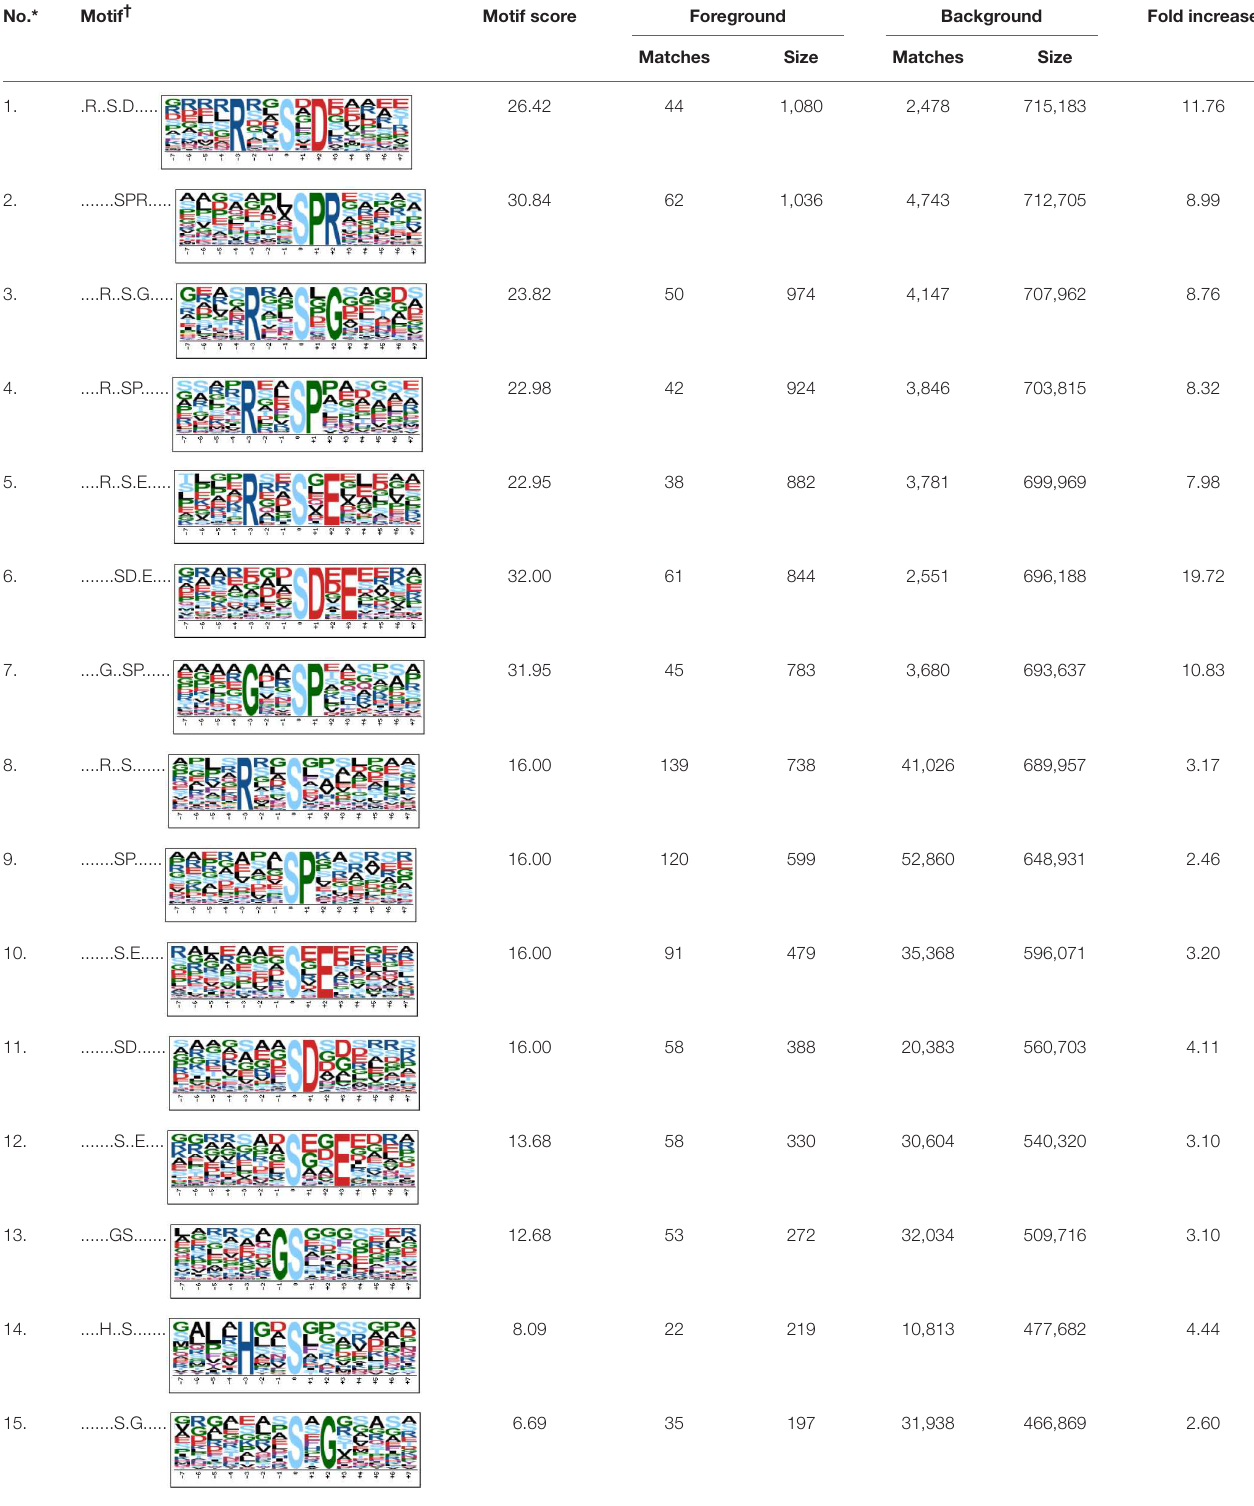
TABLE 1 | The description of the phosphorylation motifs identified by Motif X